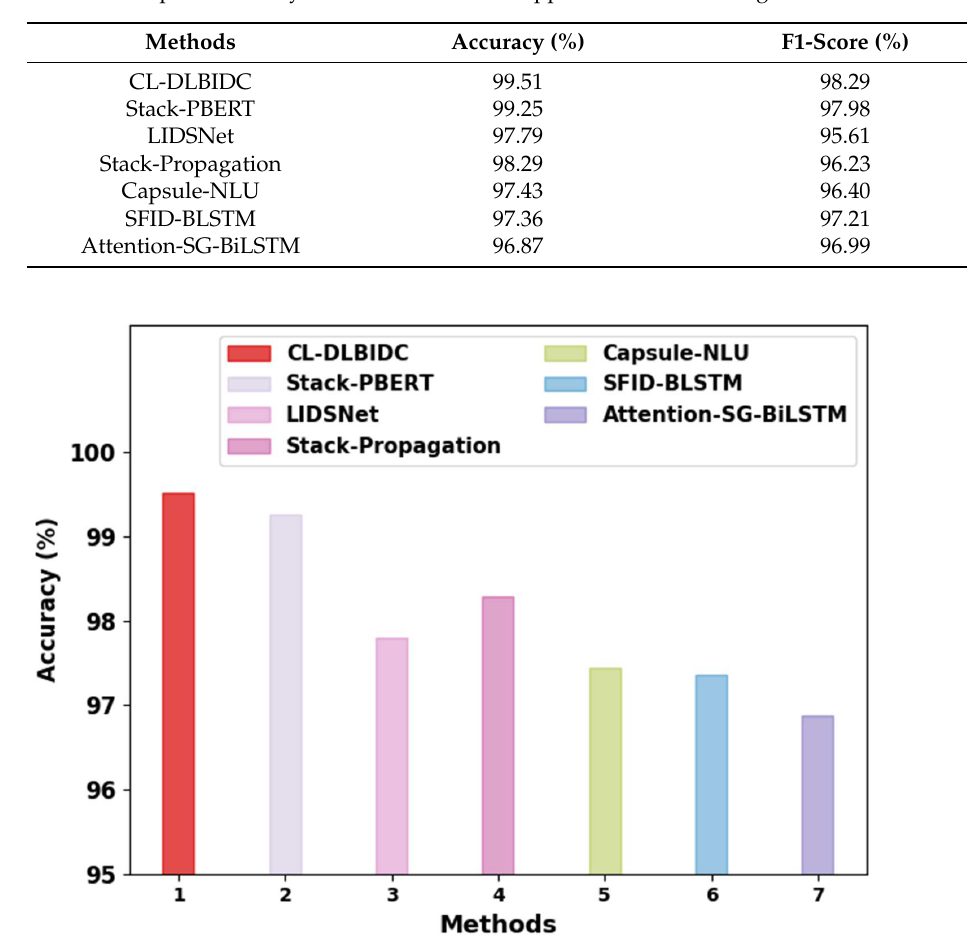
Table 4. Comparative analysis of the CL-DLBIDC approach with recent algorithms.